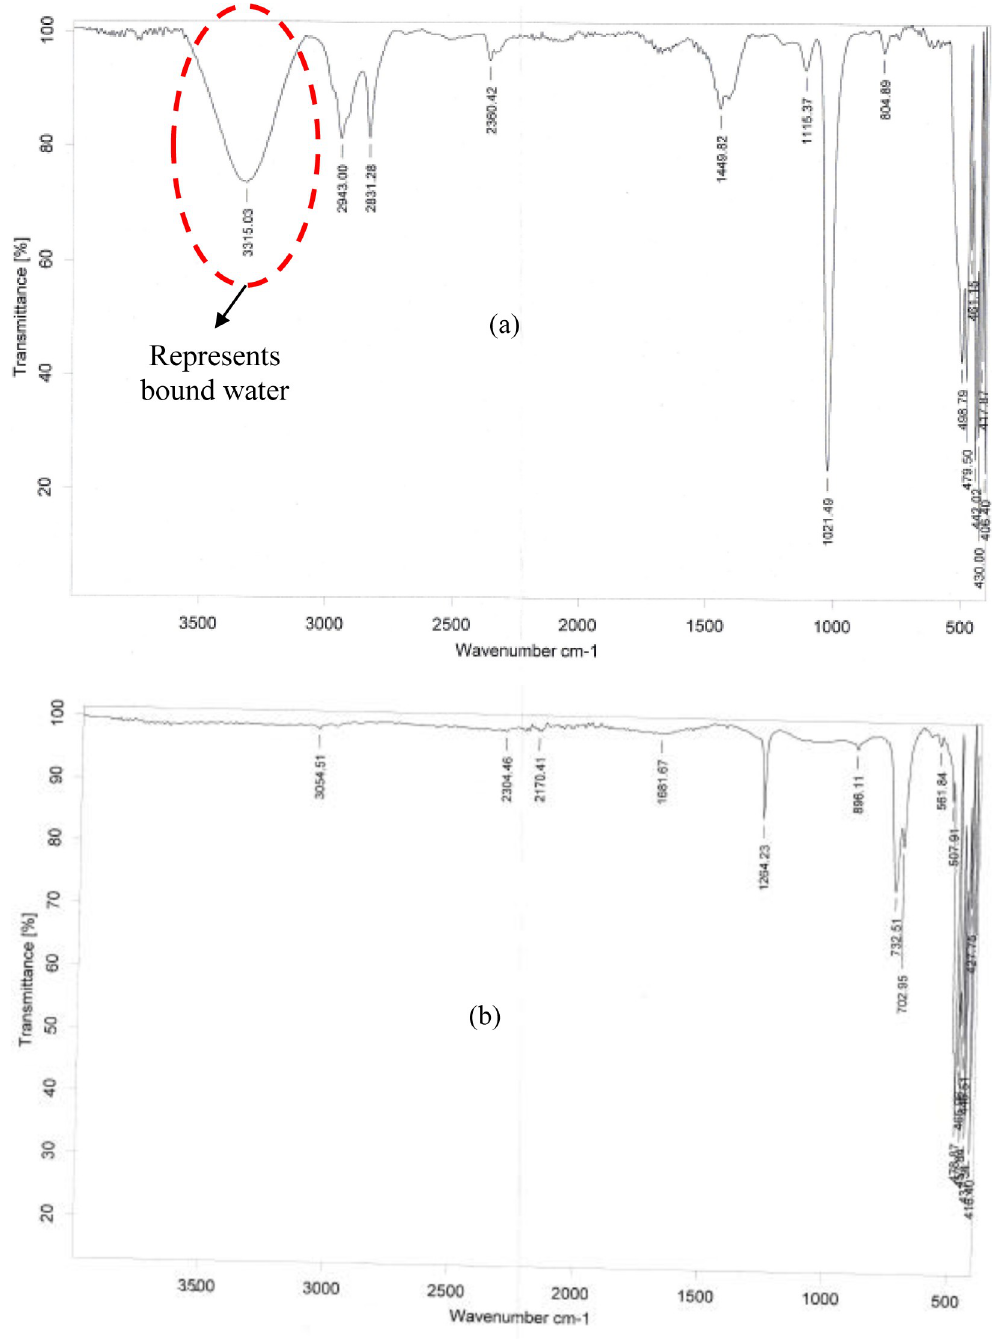
Fig 5. FTIR spectrum showing transmittance values versus the wavenumber of two samples. A strong peak at ~3300 cm -1 in (a) indicates the presence of water in the crust. Such a peak was absent (b) in case of completely dry (unused) glass